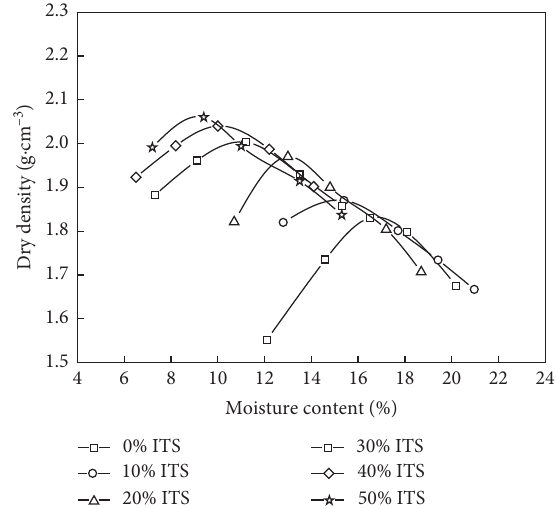
Figure 5: Compaction curves of the ITS treated expansive soil.